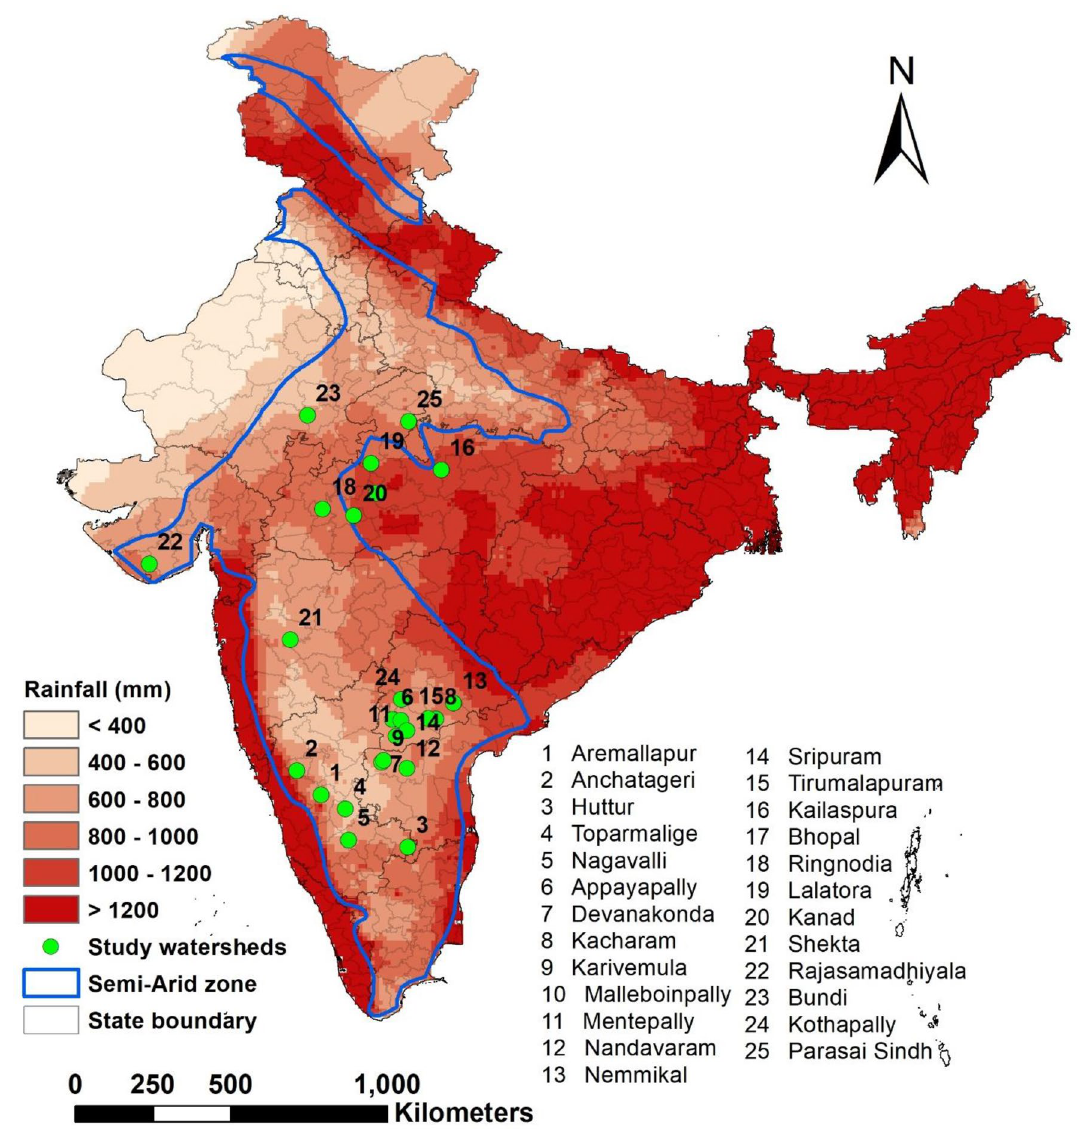
Figure 1. Location of 25 watersheds studied across different rainfall regions in the Indian semi-arid tropics. Watershed numbers 4, 12, 13, 16, 17, 18, 19, 20, 21 and 24 had Vertisols while the rest had